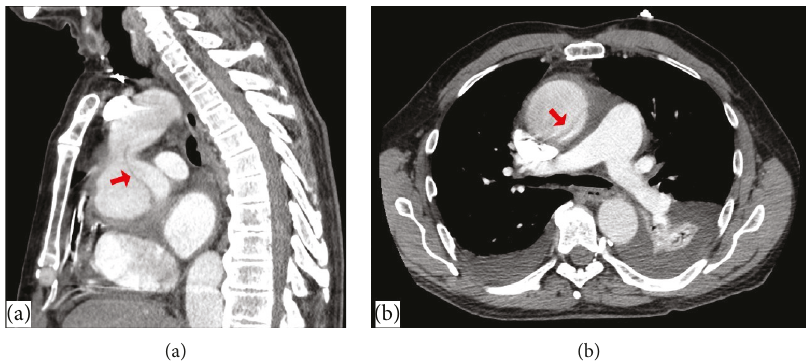
Figure 4: CT scan of the abdomen showing acute ascending thoracic aortic aneurysm measuring up to 7.5 cm with a dissection of the proximal ascending thoracic aorta originates approximately 1.3 cm above the aortic root. (a) Sagittal view of dissection site and (b) coronal view of dissection site. The area of dissection highlighted with an